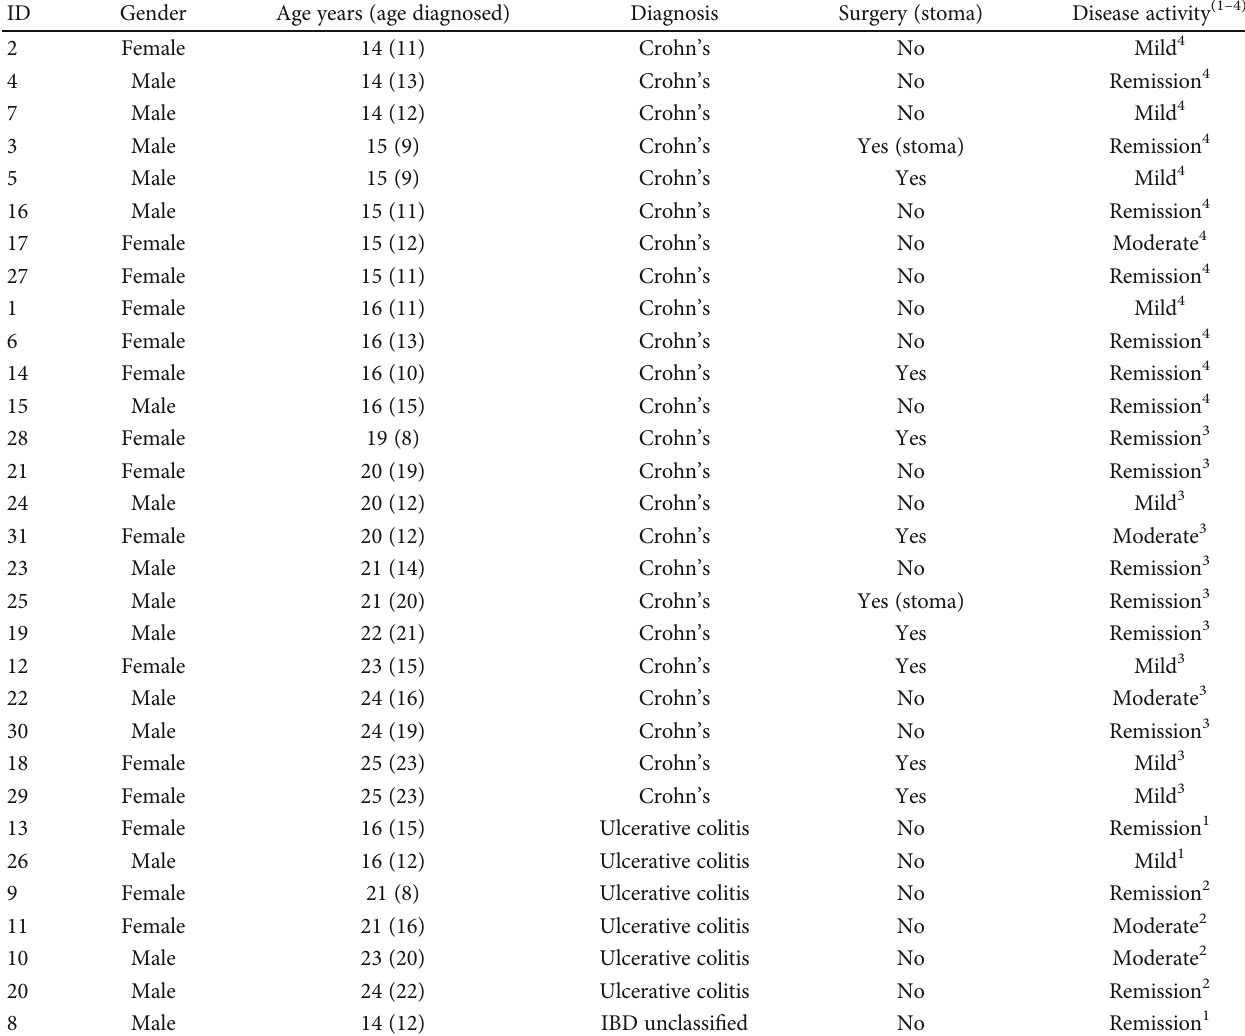
1 Paediatric Ulcerative Colitis Activity Index (PUCAI); 2 Simple Clinical Colitis Activity Index (SSCAI); 3 Harvey-Bradshaw Index (HB Index); 4 weighted Paediatric Crohn ’ s Disease Activity Index